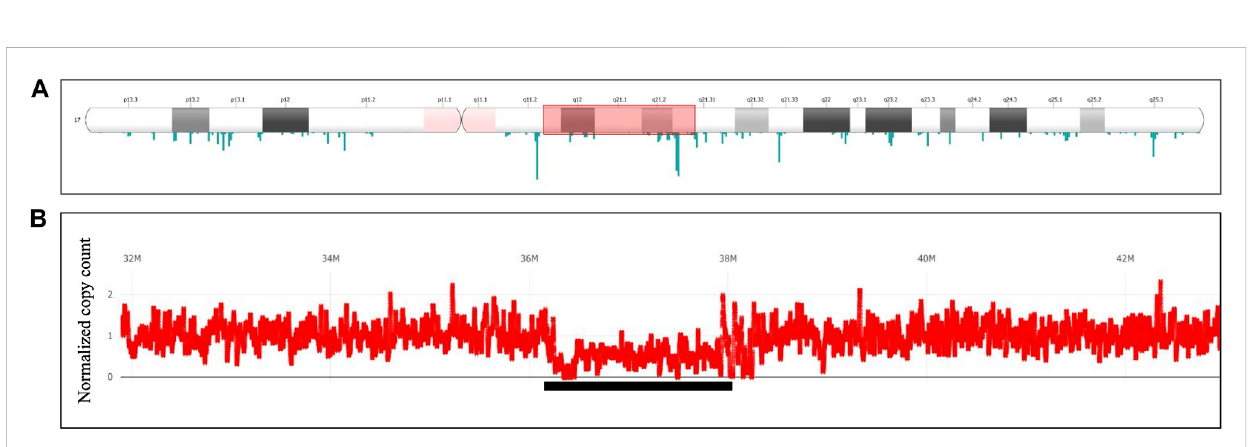
FIGURE 8 Heterozygous deletionof ~~2 Mb Deletion in 17q12q12. Long read WGS ofSample_7. (A) Ideogram depicting chromosome17. The whole length of chromosome 17 with both arms (p, q) and a centromere is shown, including the banding pattern. Shaded fragment around q12-q21.2 indicates region of interest that is magni fi ed in panel (B) Depth of coverage distribution over the selected fragment. Axis Y indicates normalized copy counts, with average count 1 equivalent to normal 2 copies of the chromosome. Underlined is a region with average copy count drop to ~0.5 hence representing heterozygous